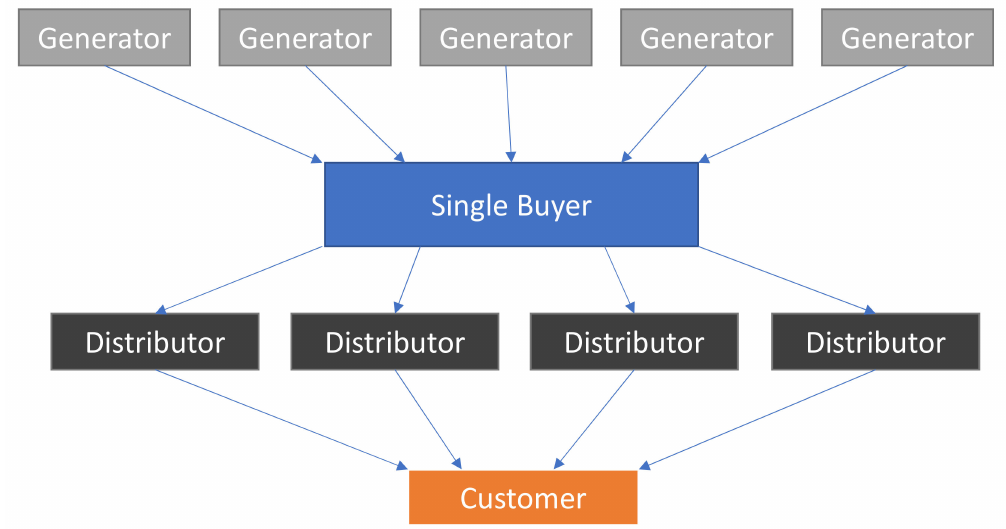
Figure 8. Single-buyer model (adapted from